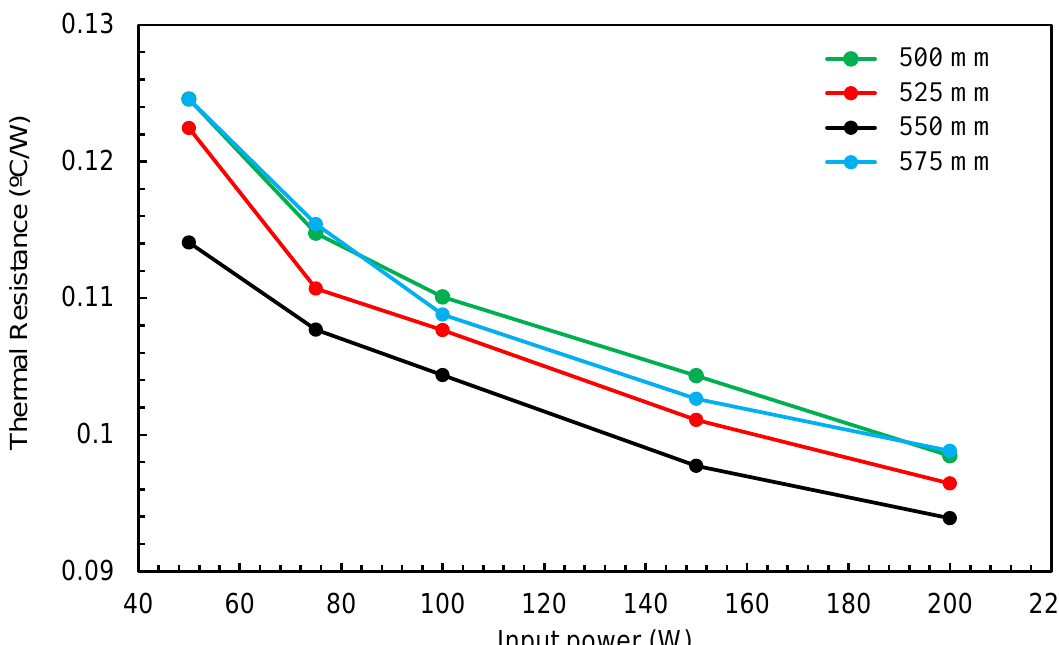
Figure 14. The effect of the riser level on thermal resistance (central disc height = 250 mm, downcomer exit = 25 mm, FR = 50%, inclination angle = 90°).